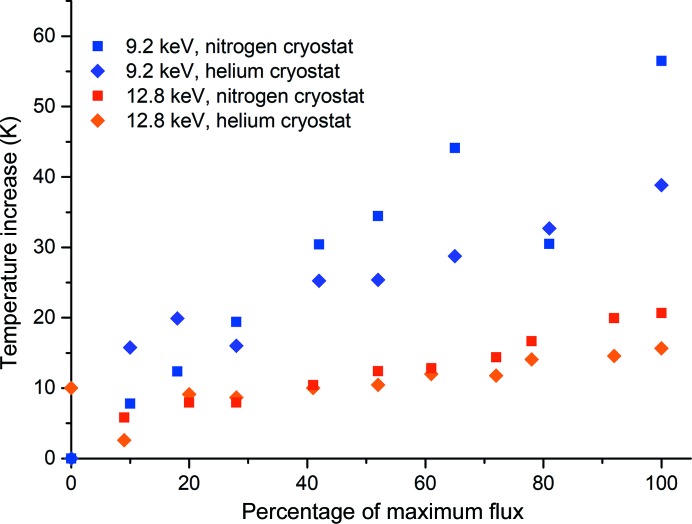
Effect of the cryostat gas on the change in temperature. To allow direct comparison of data collected at 9.2 and 12.8 keV, temperature changes are plotted against the percentage of the maximum flux rather than the flux density or dose. The flux densities and the resulting absorbed doses are the same as those shown in Fig. 4 ▸. Data were collected from a 40 µm diameter ruby sphere.